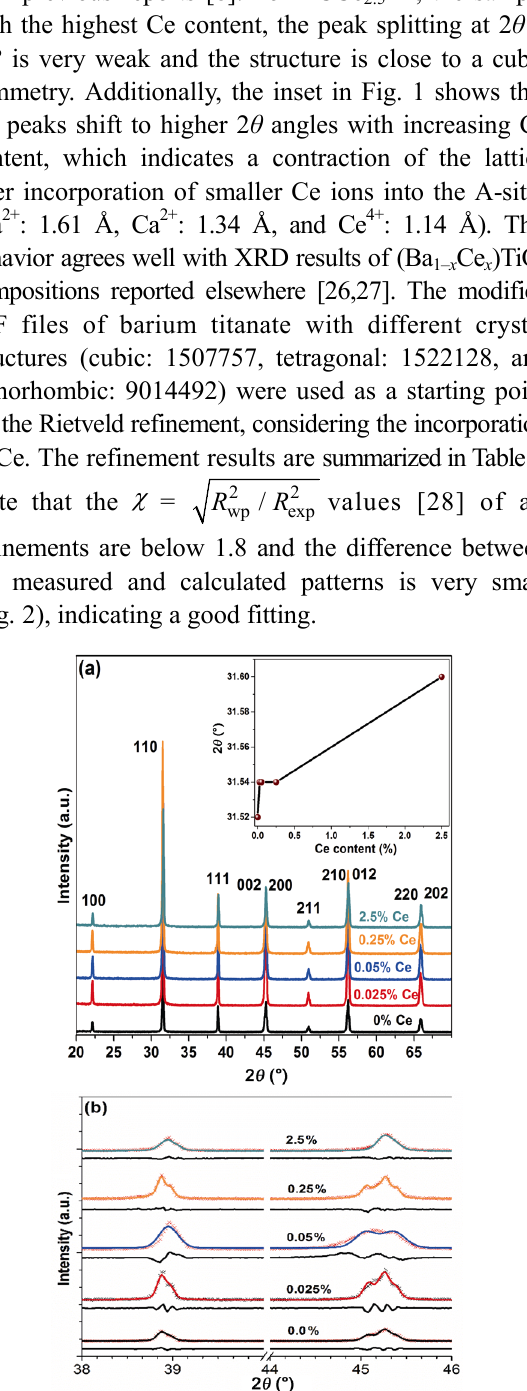
(a) The XRD patterns of Ce-doped BCZT samples sintered at 1350 ℃ . The numbers represent the pseudo-cubic peak labels. The inset shows the shift of the (110) peaks at 2 θ = 31° with increasing the Ce content. (b) The magnification of the peaks at 2 θ = 38°–40° and 44°–47°, where the symbols denote the measured values, solid colored lines the simulated pattern, and solid black lines the